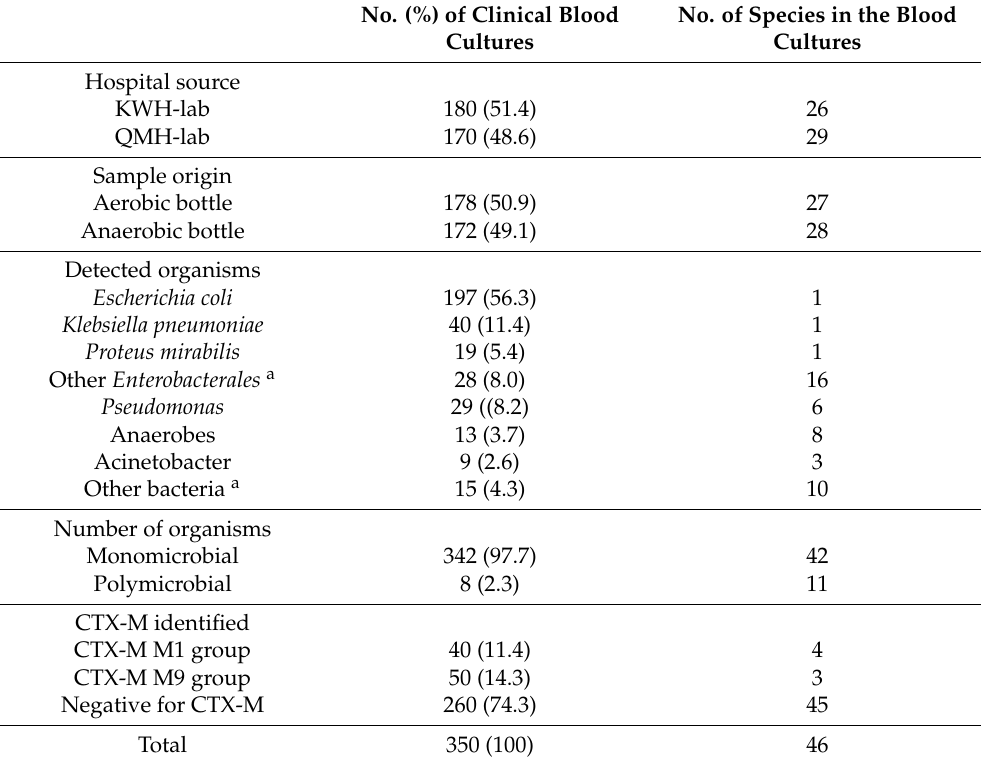
Table 2. Summary of positive clinical blood culture bottles tested in this